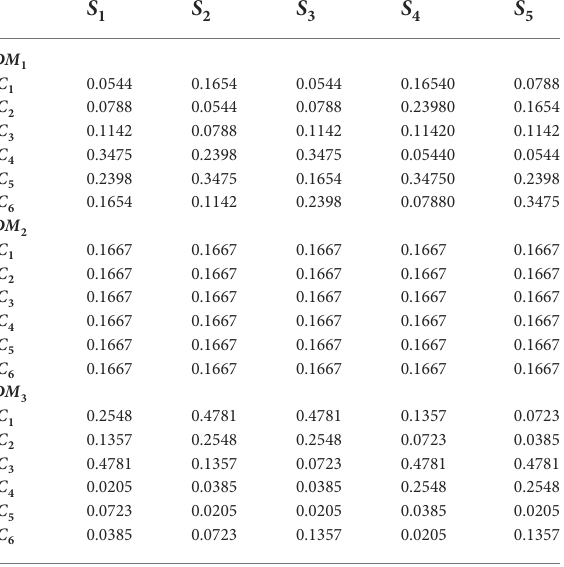
TABLE 11 Reordered ranking risk preference weights of criteria.